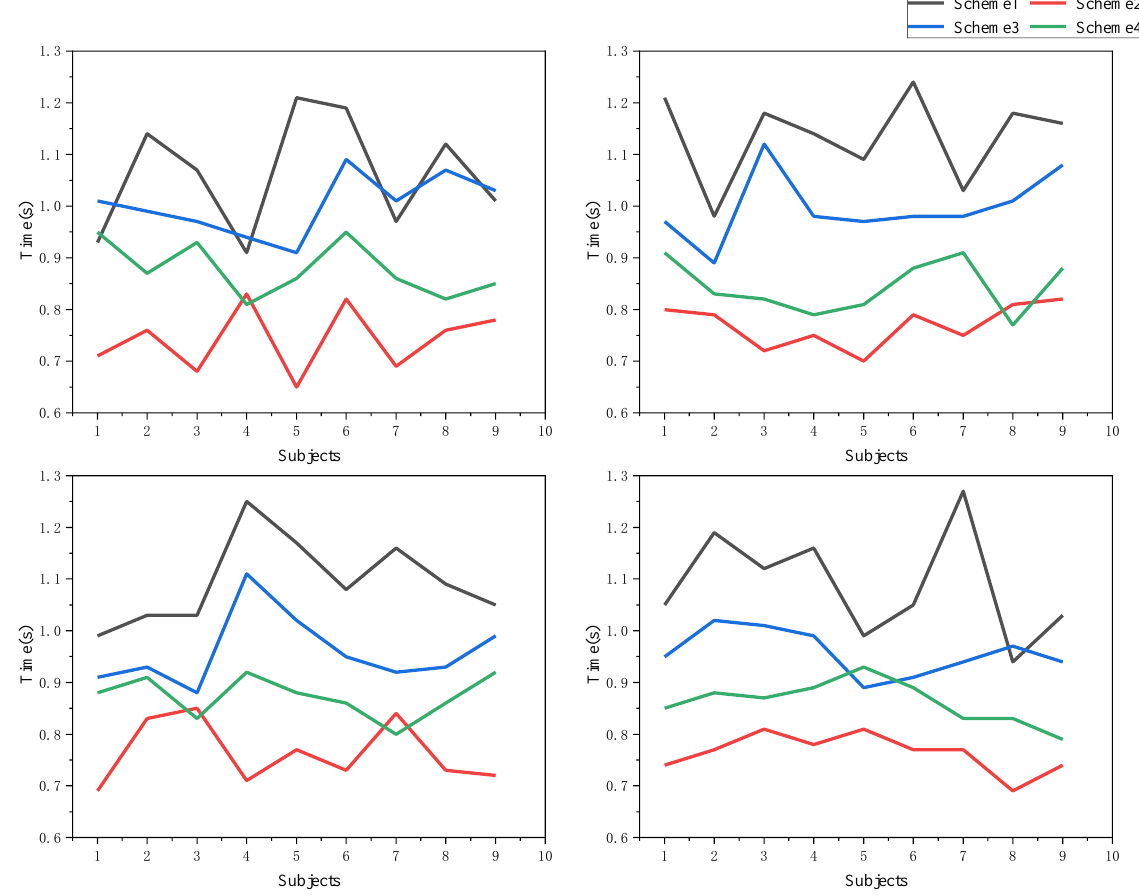
Figure 17. Time comparison of different schemes at each point.